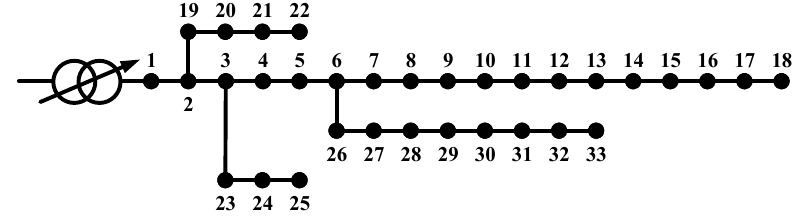
Figure 4. The model of the IEEE 33 node power system.